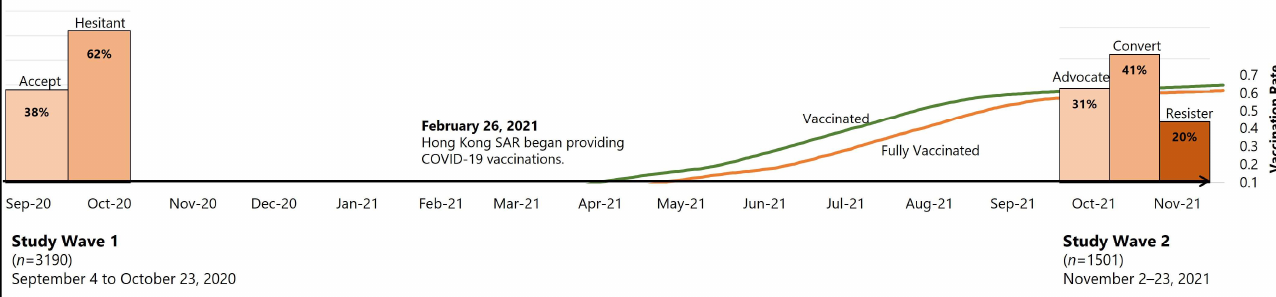
Figure 1. First wave data were collected through stratified sampling based on age, gender, and residential districts from 4 September to 23 October 2020, when COVID-19 vaccines were not available in Hong Kong. Second wave data were collected from 2–23 November 2021, when vaccination rates in Hong Kong plateaued and third-dose vaccines became available. These two waves of data fully capture psychological changes before and after vaccine availability. Vaccine advocates are defined as those who demonstrated intent to vaccinate in wave 1 and reported being fully vaccinated in wave 2. Vaccine converts are those who were hesitant to vaccinate in wave 1 but reported being fully vaccinated in wave 2. Vaccine resisters are those who were hesitant to vaccinate in wave 1 and reported being unvaccinated in wave 2.